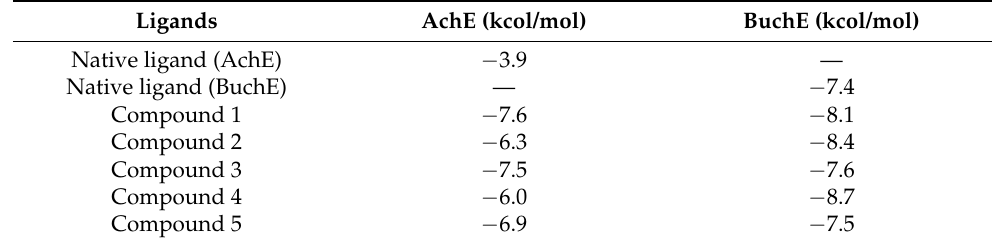
Table 3. Molecular docking of compounds 1 – 5 with AchE and BuchE.